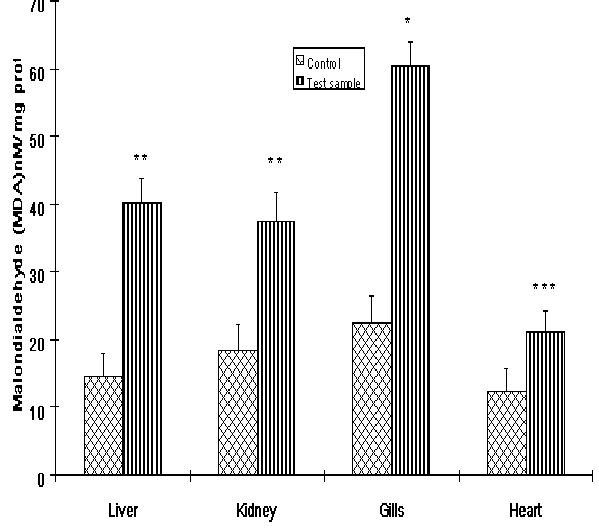
Figure 5: The levels of malondialdehyde (MDA) in the livers, kidney, Gills and heart of Clarias gariepinus from the Ogun River and Agodi farm. Values are mean ± SD of 10 fishes. Significantly different from control,* p<0.001;** p<0.01; ***p<0.05.